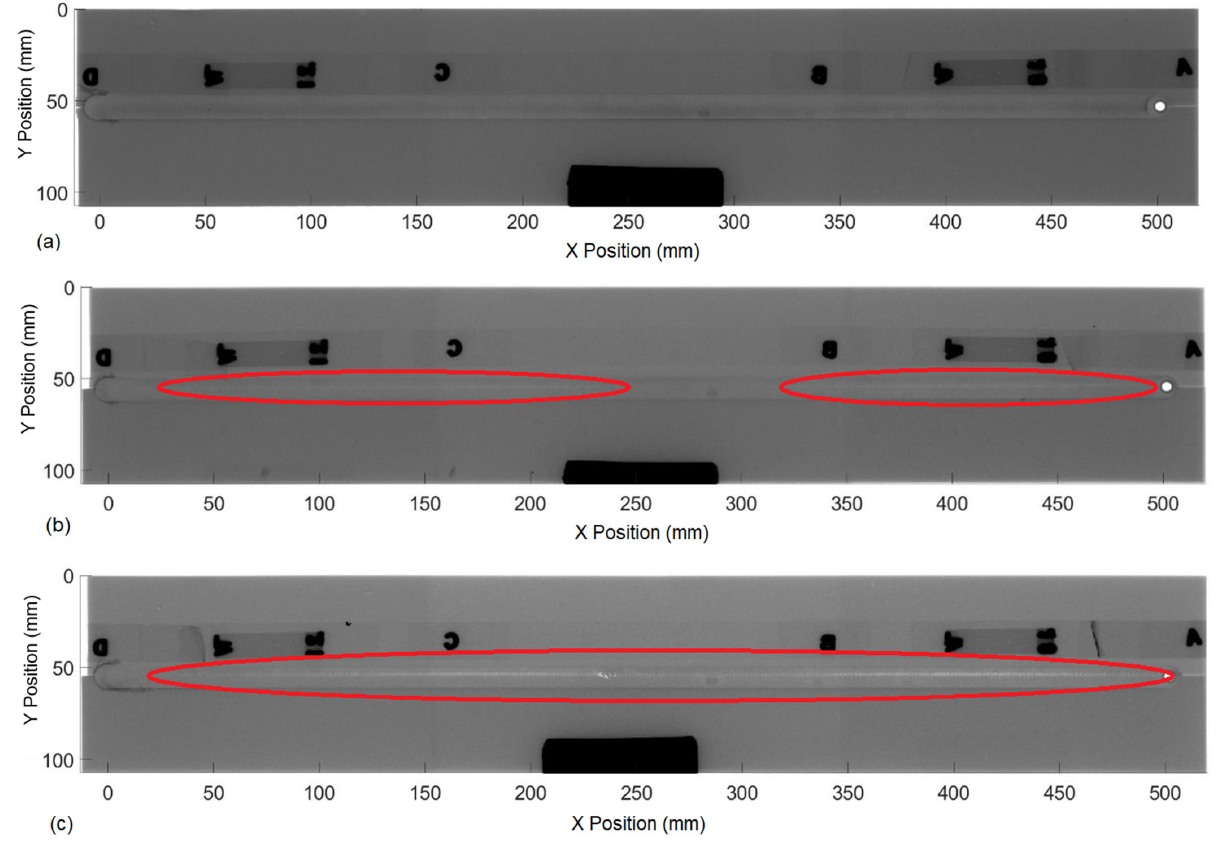
Figure 6. ( a ) An example of a non-defective weld, consistent grey color produced with parameter set 1 in Table 1. ( b ) An example of a partially defective weld, where lighter grey regions convey a defect growing and diminishing produced with parameter set 4 in Table 1. ( c ) An example of a completely defective weld, the defect can be visualized by the light area in the center of the weld produced with parameter set 6 in Table 1 The red eclipse highlight the location of a defect within the